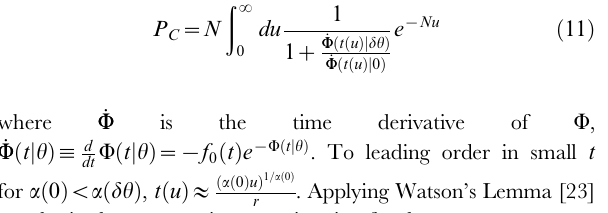
the neural stochastic response. The dashed line shows the analytical prediction of equation 9 with a ~ 1 .